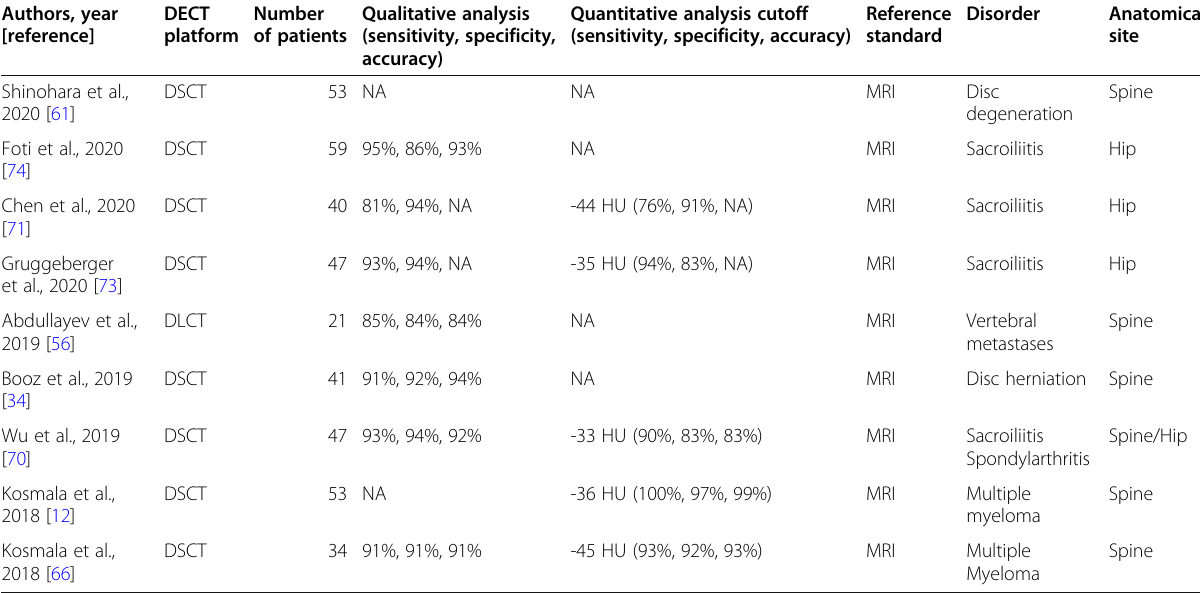
Table 3 Virtual non-calcium computed tomography potential to visualize non-traumatic bone marrow edema on dual-energy scans of spine and pelvic girdle